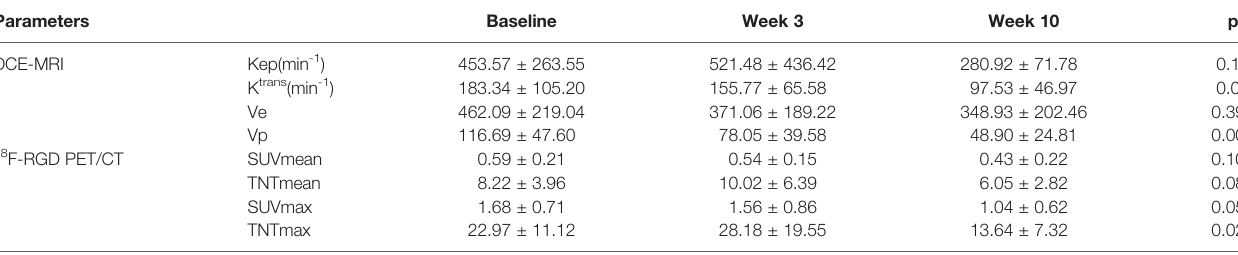
TABLE 3 | Treatment-dependent alterations of 18F-RGD PET and DCE-MRI parameters.